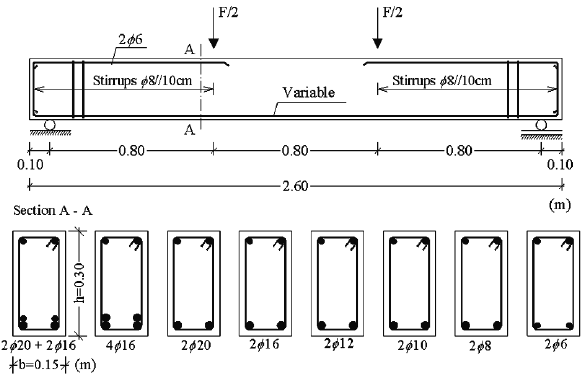
Fig. 1. Geometry and details of test beams (Bernardo et al.